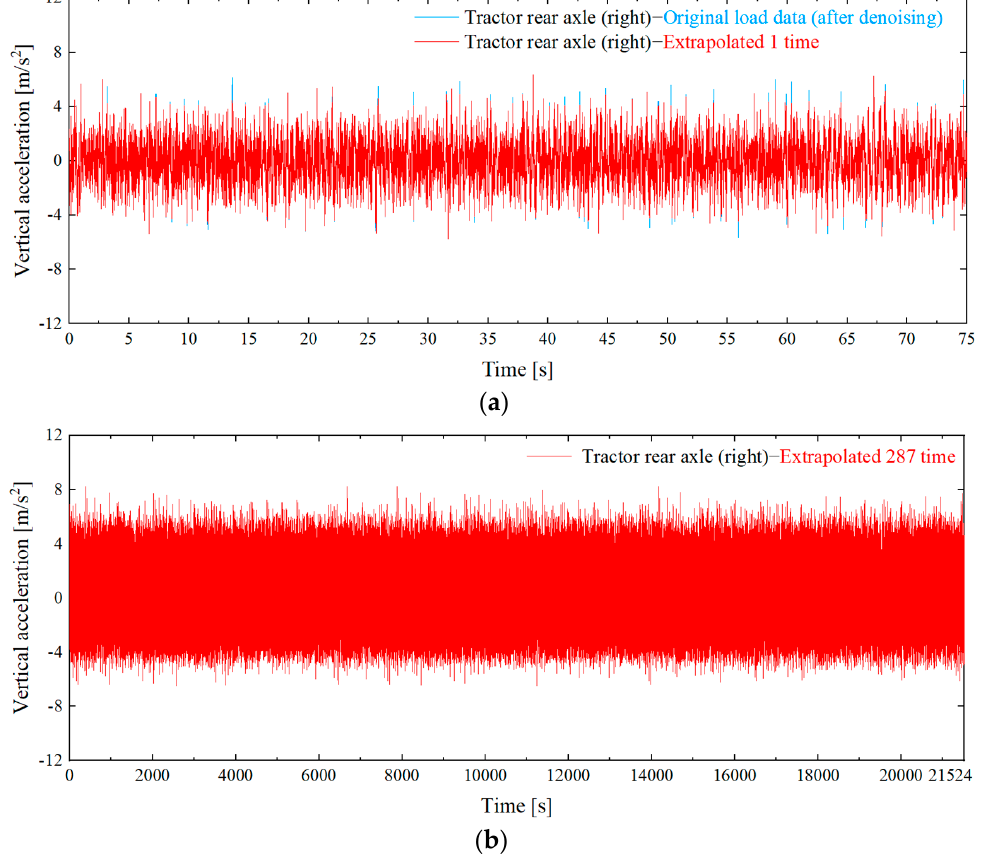
Figure 16. Load data comparison curve: ( a ) Comparison of original load and extrapolated 1-time load spectrum; ( b ) Ground load spectrum extrapolated to the full life ‐ cycle.